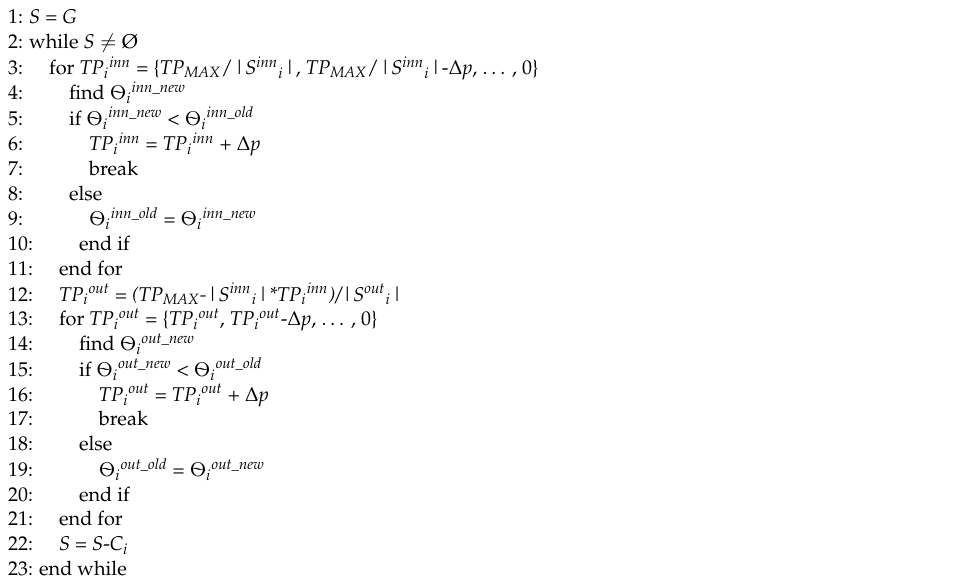
Algorithm 1. Transmit Power Allocation (TPA)